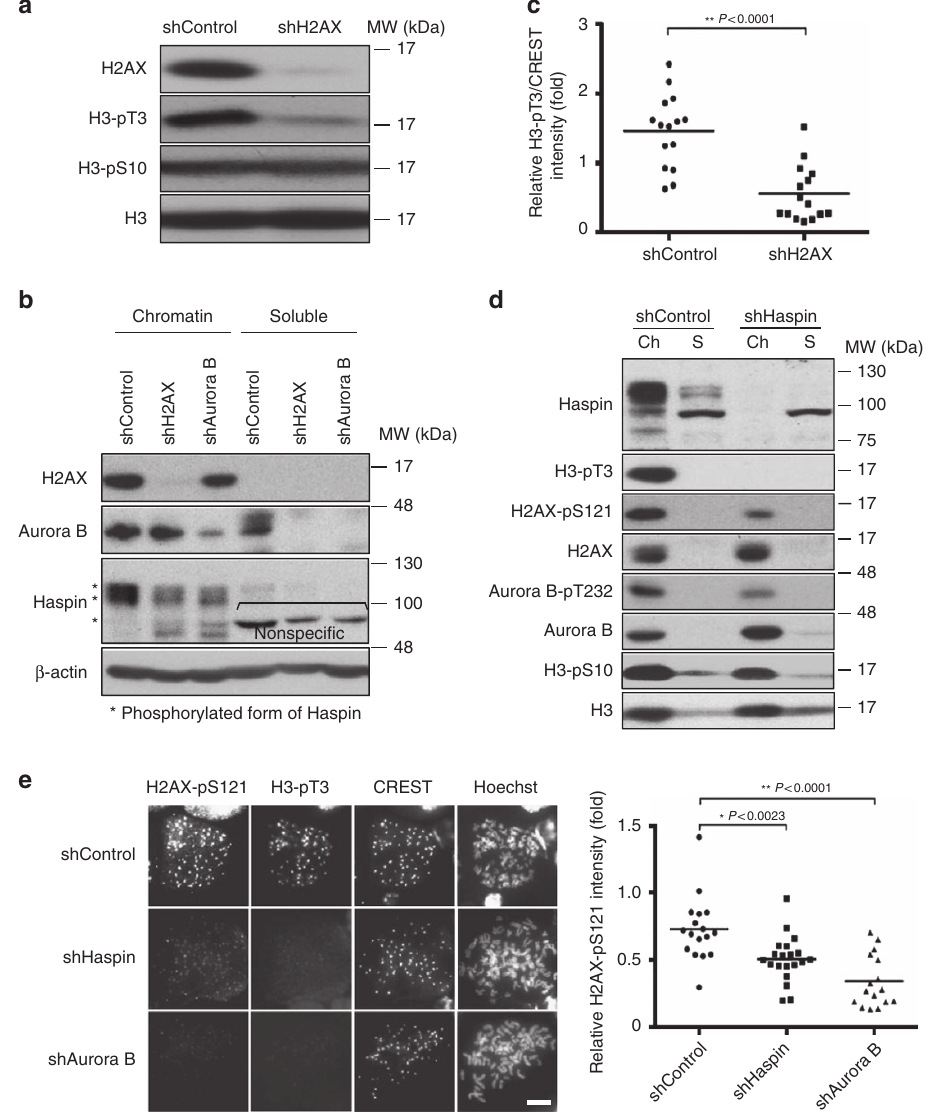
Figure 4 | H2AX-pS121 functions upstream of Haspin-H3-pT3. ( a ) Chromatin fractions as in Fig. 2d were subjected to immunoblotting using the indicated antibodies. ( b ) HeLa cells expressing the Dox-inducible shControl, shH2AX or shAurora B were treated as in Fig. 2d. After mitotic shake-off, chromatin (Ch) and soluble (S) fractions from mitotic cells were subjected to immunoblotting using the indicated antibodies. ( c ) Chromosome spreads from HeLa cells as in Fig. 3b were stained with antibodies against H2AX, H3-pT3 and CREST (see Supplementary Fig. 8c). Signal intensities of H3-pT3 at the centromere were measured and CRESTwas used as a control of the centromeric signal intensity ( n ¼ 15 cells, 5 kinetochores were measured per each cell, Student’s t -test). ( d ) HeLa cells expressing the Dox-inducible shControl and shHaspin were treated as in Fig. 2d. After mitotic shake-off, chromatin (Ch) and soluble (S) fractions from mitotic cells were subjected to immunoblotting using the indicated antibodies. ( e ) Chromosome spreads from HeLa cells expressing the shControl, shHaspin or shAuroraB were stained with antibodies against H2AX-pS121, H3-pT3 and CREST. DNA was counterstained with Hoechst. Representative images are shown (left). Scale bars, 10 m m. Signal intensities of H2AX-pS121 at the centromere were measured (right) and CRESTwas used as a control of the centromeric signal intensity ( n Z 15 cells, 5 kinetochores were measured per each cell, Student’s t